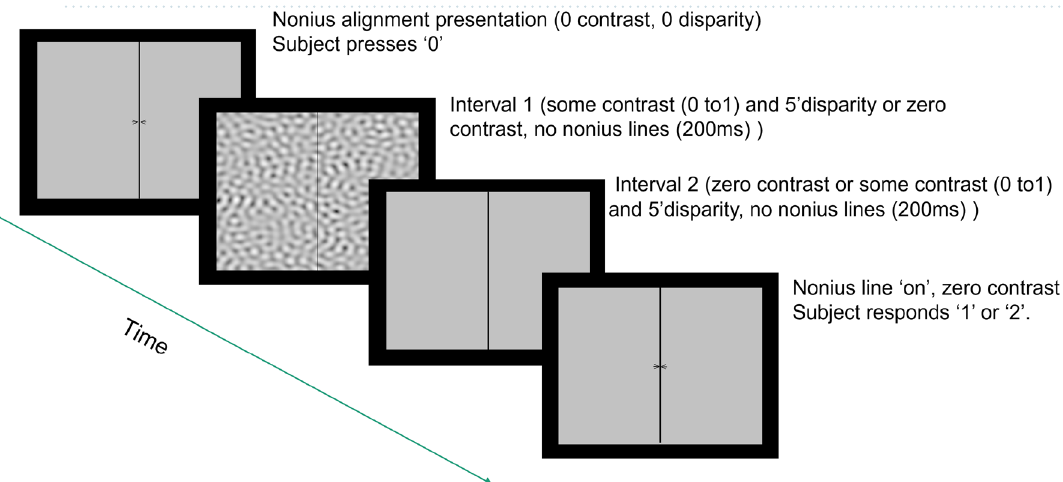
Figure 9. Sequence of events in a trial in the psychophysical steady noise contrast detection experiment. Stimuli were presented with fixed vertical disparity, and subjects indicated which of the two intervals had the stimulus. Presentation was brief to prevent a vergence response so that retinal disparity was consistent from trial to